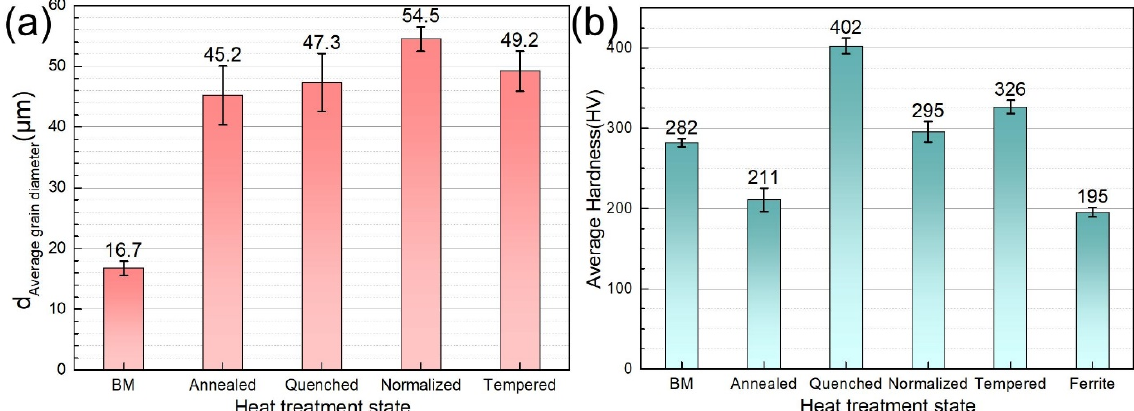
Figure 4. Average grain diameter ( a ) and Vickers microhardness ( b ) of 690 MPa grade marine engineering steel after different heat treatments and ferrite microstructure in the annealed steel.